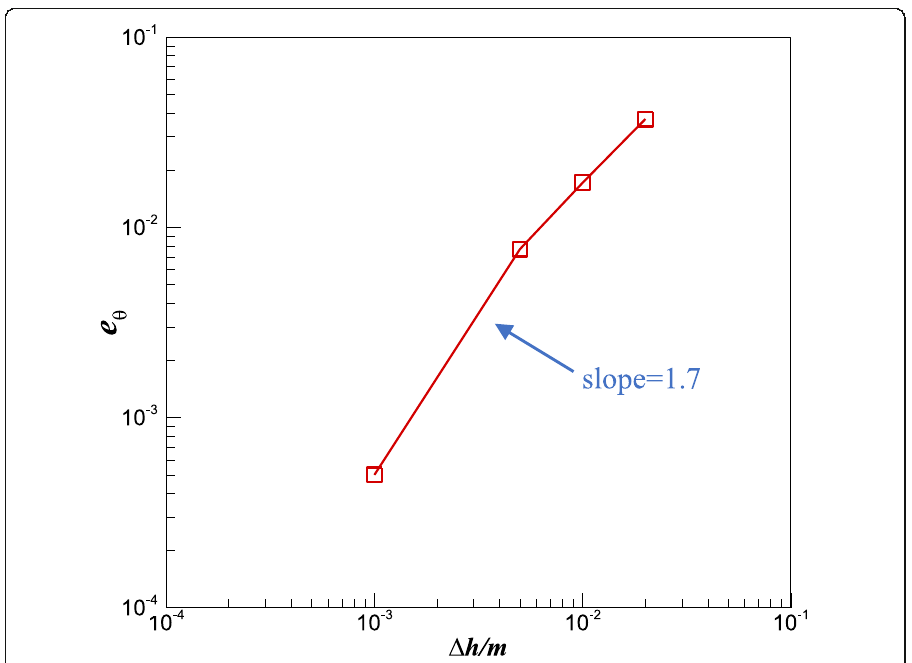
Fig. 4 Convergence of numerical error versus grid step for supersonic oblique